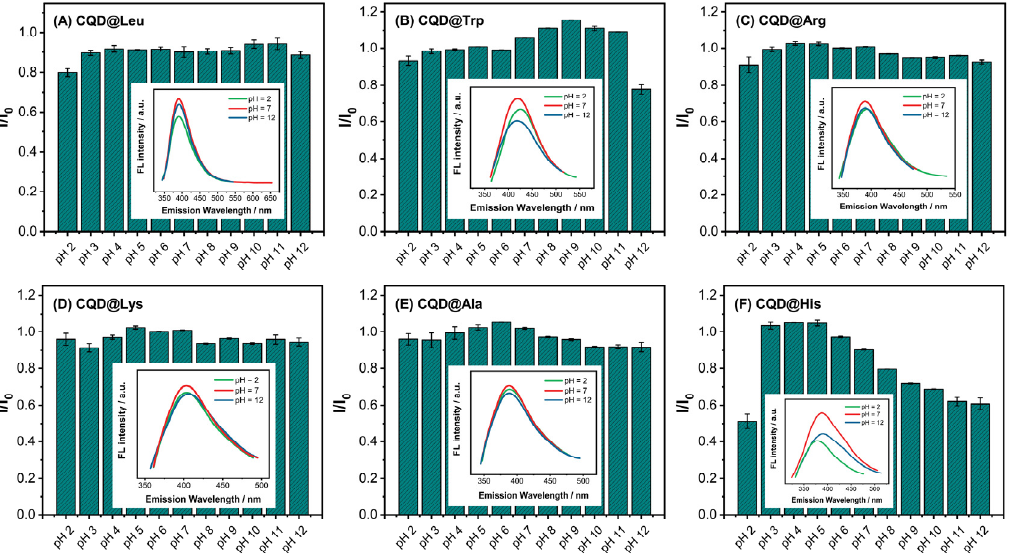
Figure 9. Fluorescence intensity vs. pH variation for ( A ) CQD@Leu, ( B ) CQD@Trp, ( C ) CQD@Arg, ( D ) CQD@Lys, ( E ) CQD@Ala, ( F ) CQD@His (recorded at λ EX = 340 nm).